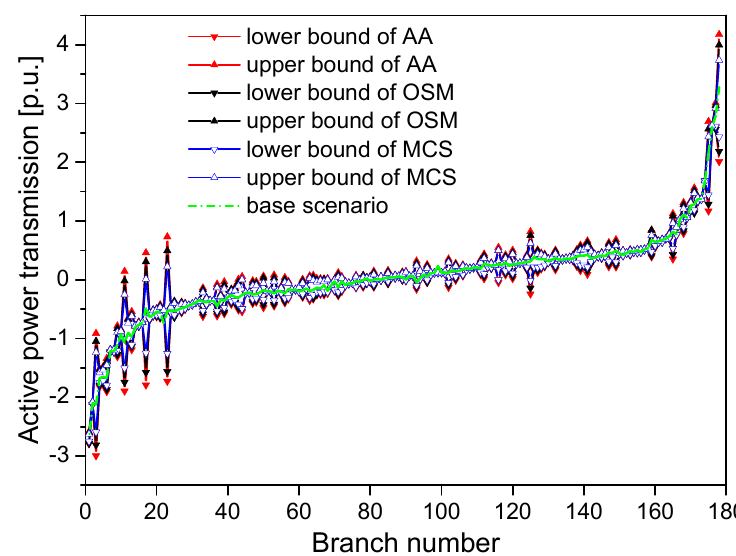
Figure 13. Load voltage magnitude results obtained by different methods.